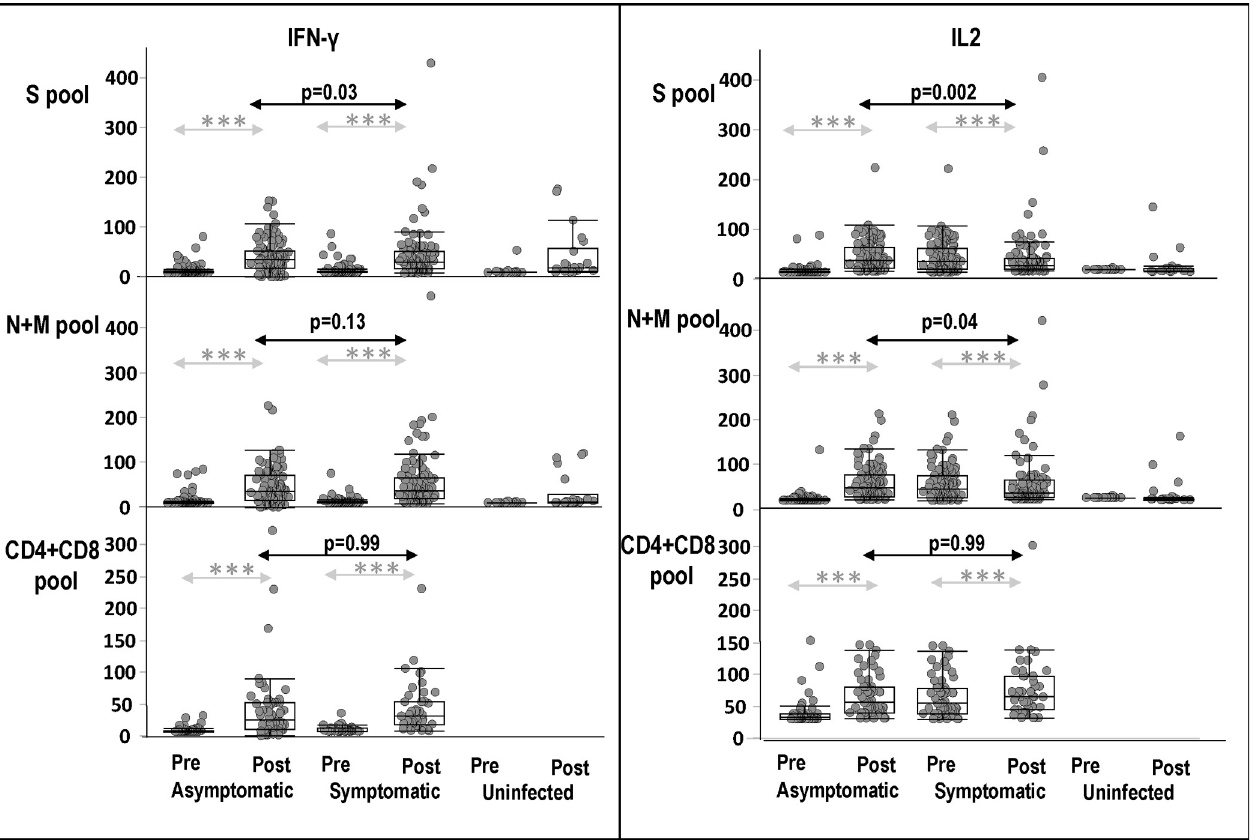
Fig 2. Magnitudes of IFN- γ and IL2 responses of asymptomatic, symptomatic participants before and after infection, and healthy uninfected participants, to S, N+M, and CD4+CD8 pools. Pre-infection (Pre) and maximum IFN- γ and IL2 responses post-infection (Post) to S, N+M, and CD4+CD8 peptide pools of asymptomatic and symptomatic participants, and healthy uninfected participants (Pre = baseline and Post = post-baseline). Significance of differences between Pre and Post ��� p = < 0.001.